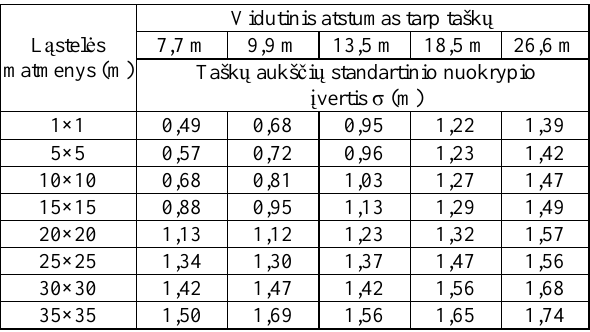
Table 2. Accuracy analysis of DEM created by spline method Vidutinis atstumas tarp tašk